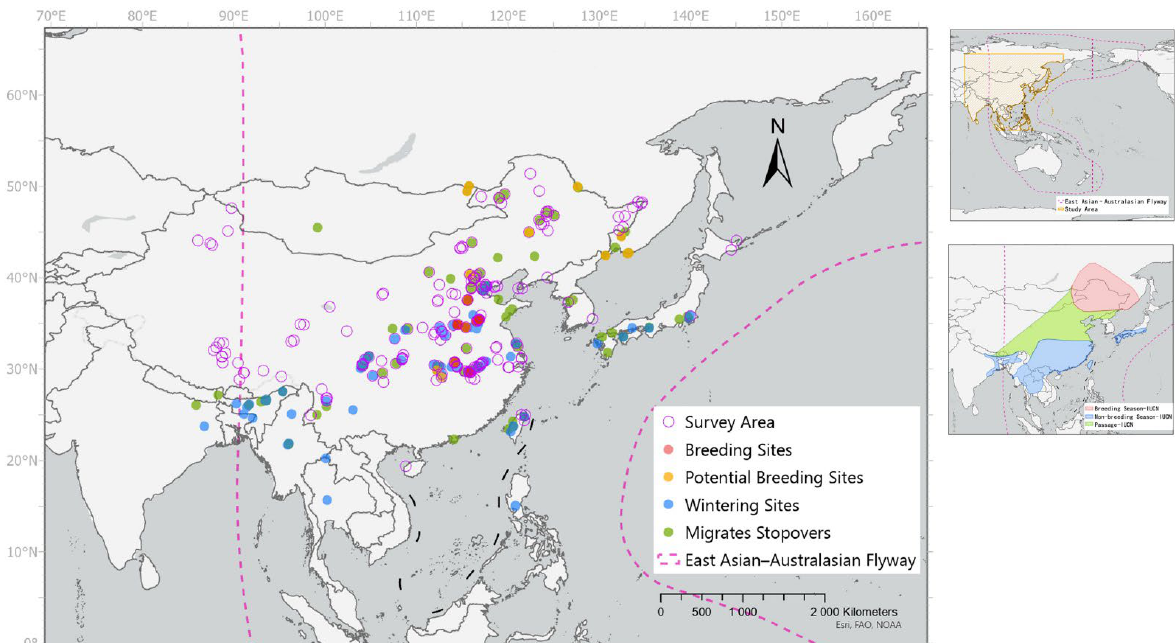
Figure 1. Baer’s Pochard survey sites and historical presence sites for modelling. The study area within the East Asian–Australasian Flyway is shown in inset upper right, and inset lower right is the current distribution map by IUCN.